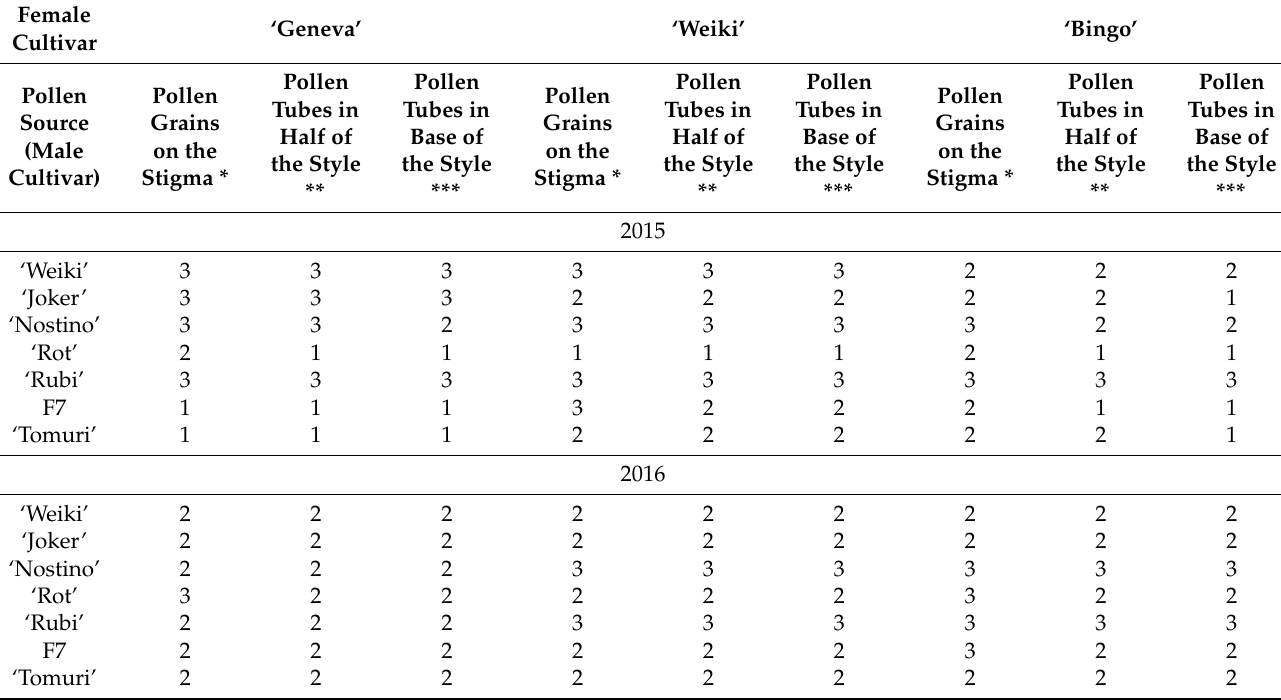
Table 3. Comparison of female–male genotypes compatibility in 2015 and